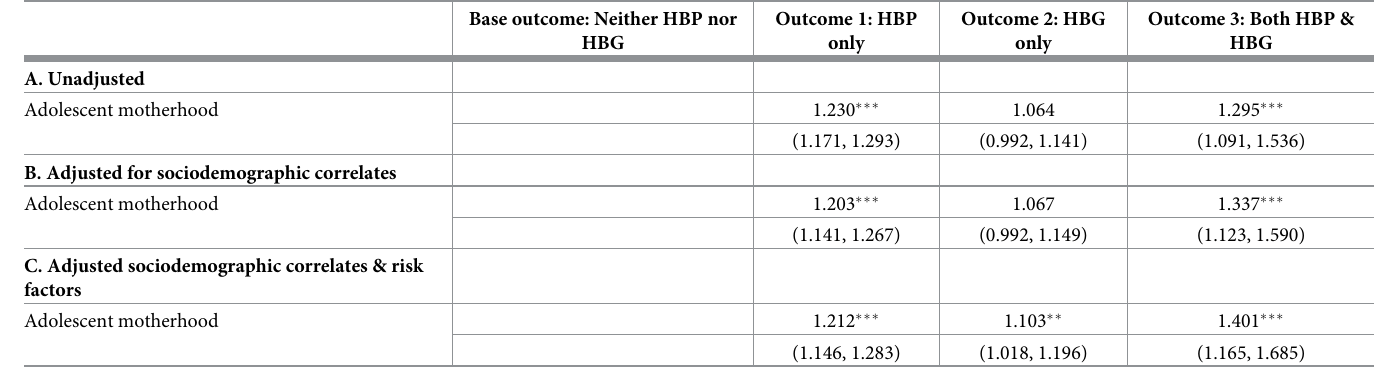
Table 4. Unadjusted and adjusted relative risk ratios for adolescent motherhood